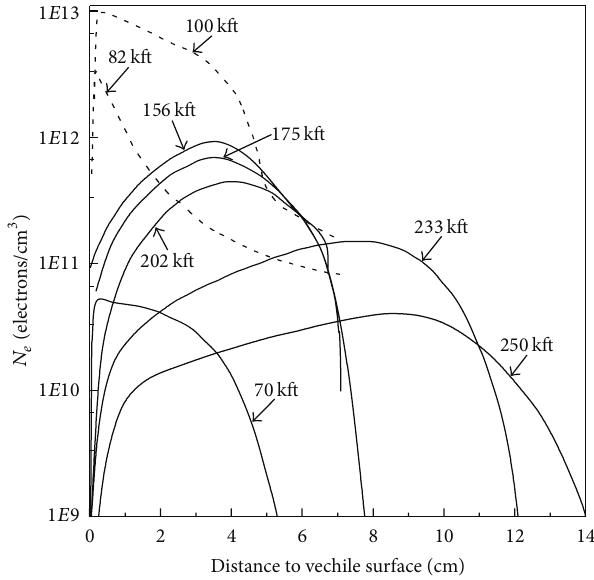
Figure 1: Electron density profiles at different altitudes for RAM-C vehicles (reprinted courtesy of